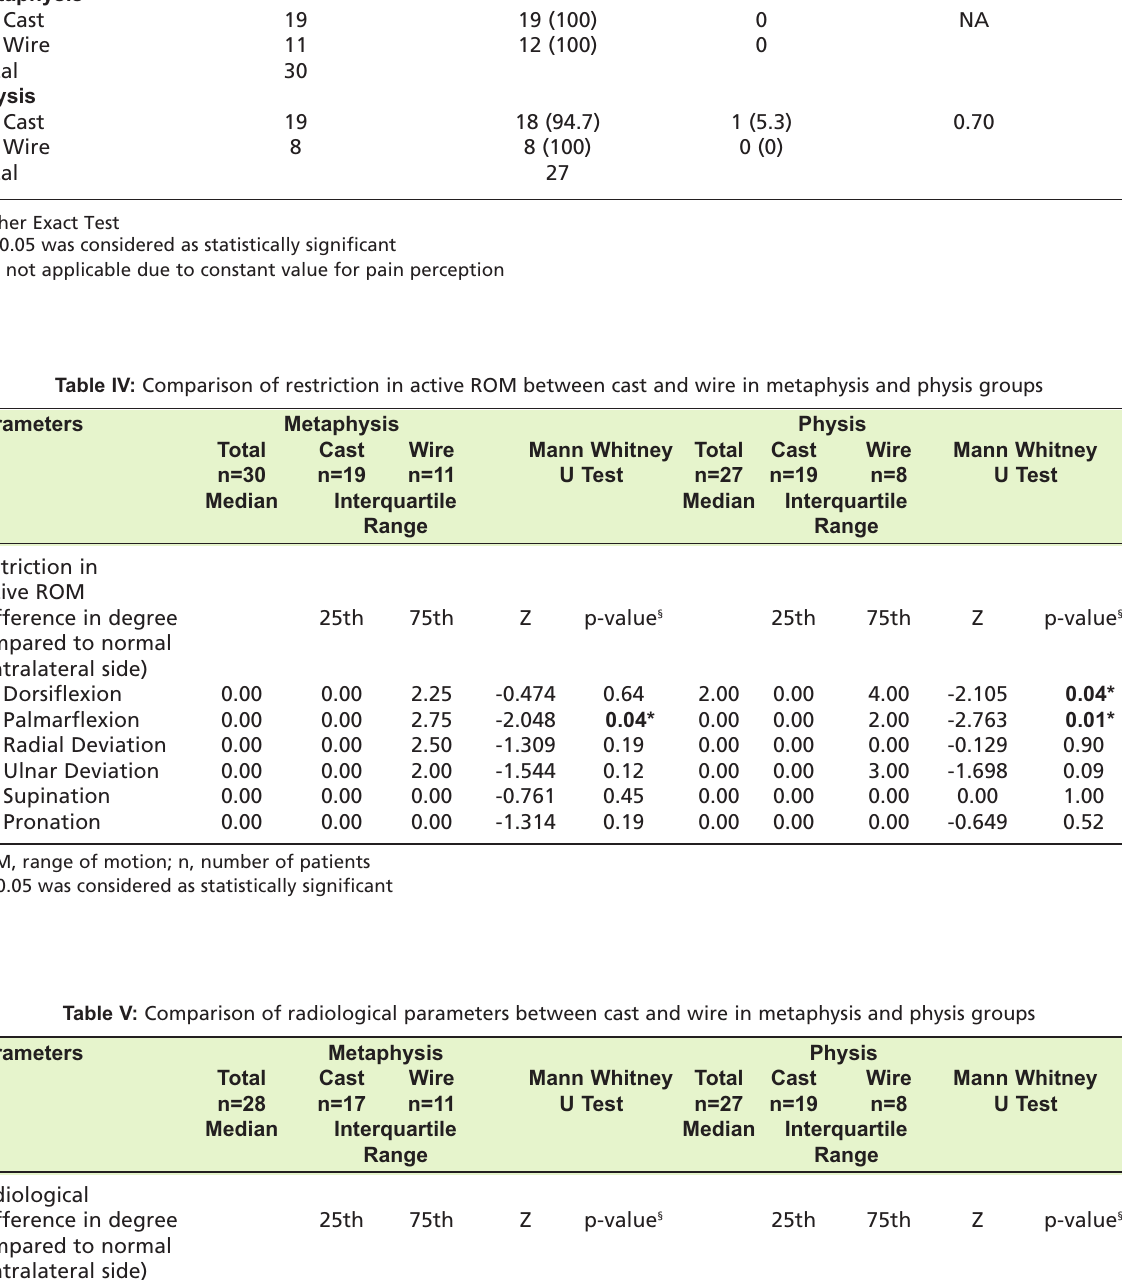
Comparison of radiological parameters between cast and wire in metaphysis and physis groups